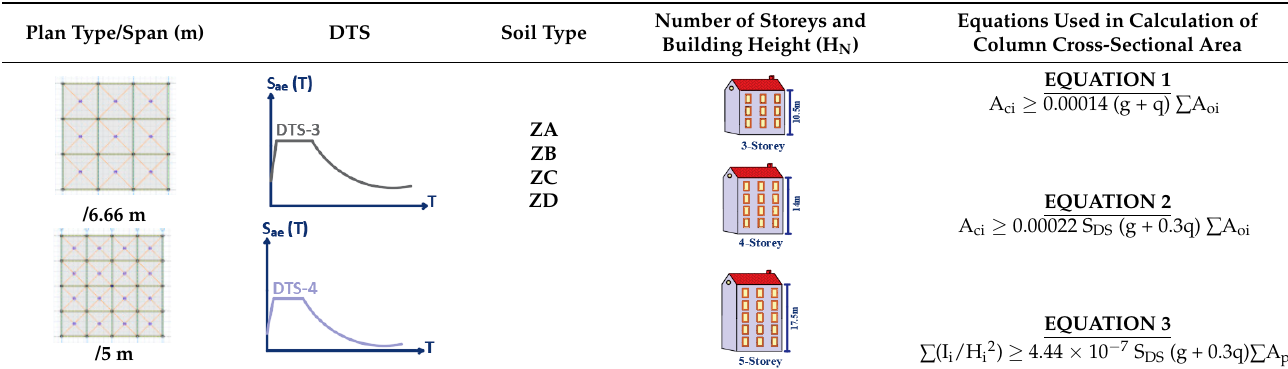
Table 3. Selection of beam reinforcements according to the general rules of TBEC-2019 (Section 17).